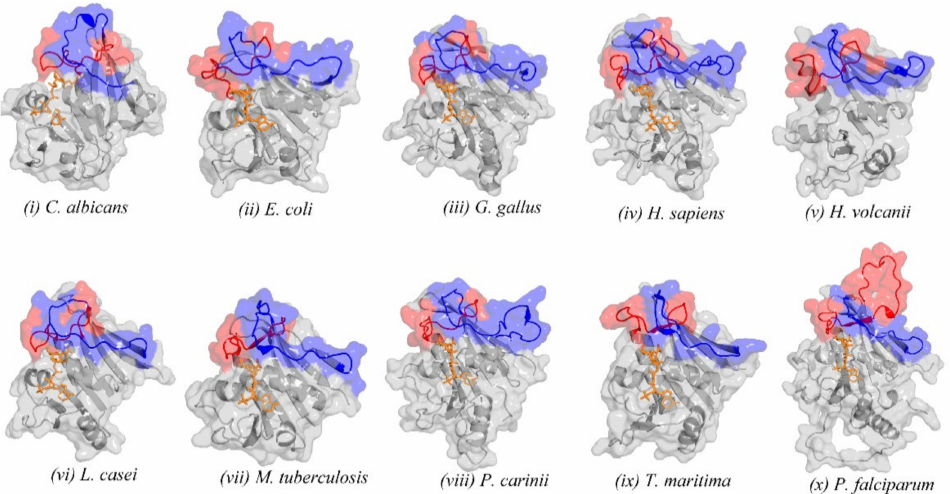
Figure 4. ( i – ix ) Structures of the nine molecular replacement templates used in solving the P. falciparum DHFR structure, highlighting loop 1 and loop 2. ( x ) Structure of the P. falciparum DHFR highlighting loop 1 and loop 2, with the slipknot-like conformation. Loop 1 is coloured in red, and the loop into which it docks (Loop 2) is coloured blue, while the rest of the structure is coloured grey, with the NADP cofactor represented as sticks and coloured in